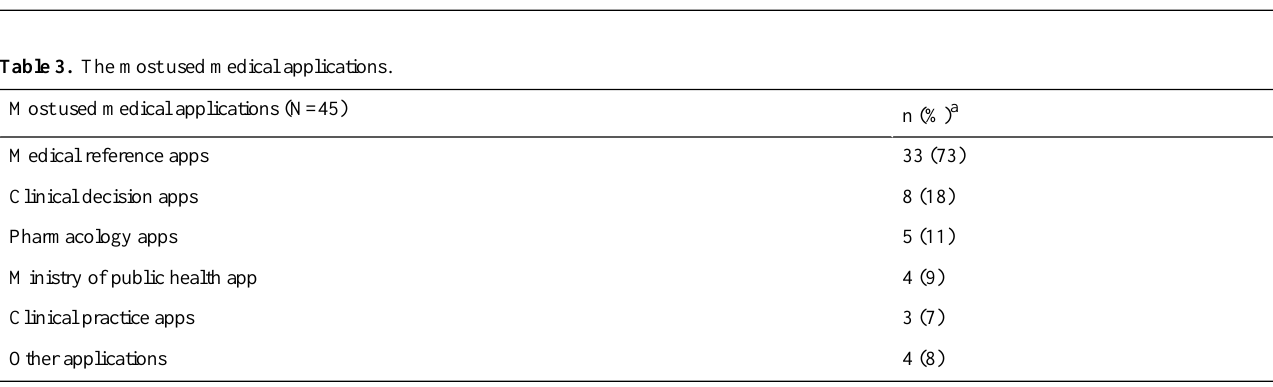
Table 3. The most used medical